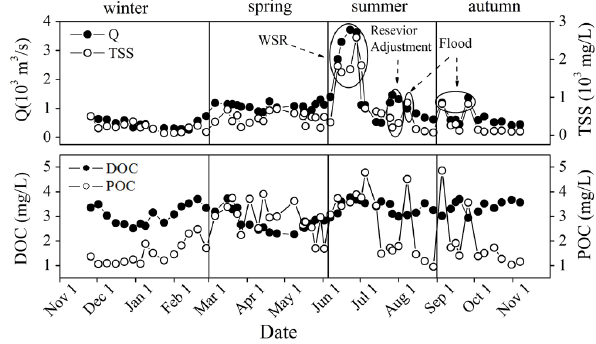
Fig. 3. Distributions of discharge ( Q ), TSS, POC, and DOC at the Huayuankou hydrological station between November 2005 and November 2006. WSR denotes the water and sediment regulation period and reservoir adjustment indicates that reservoirs start to re- lease water, but not sediment.